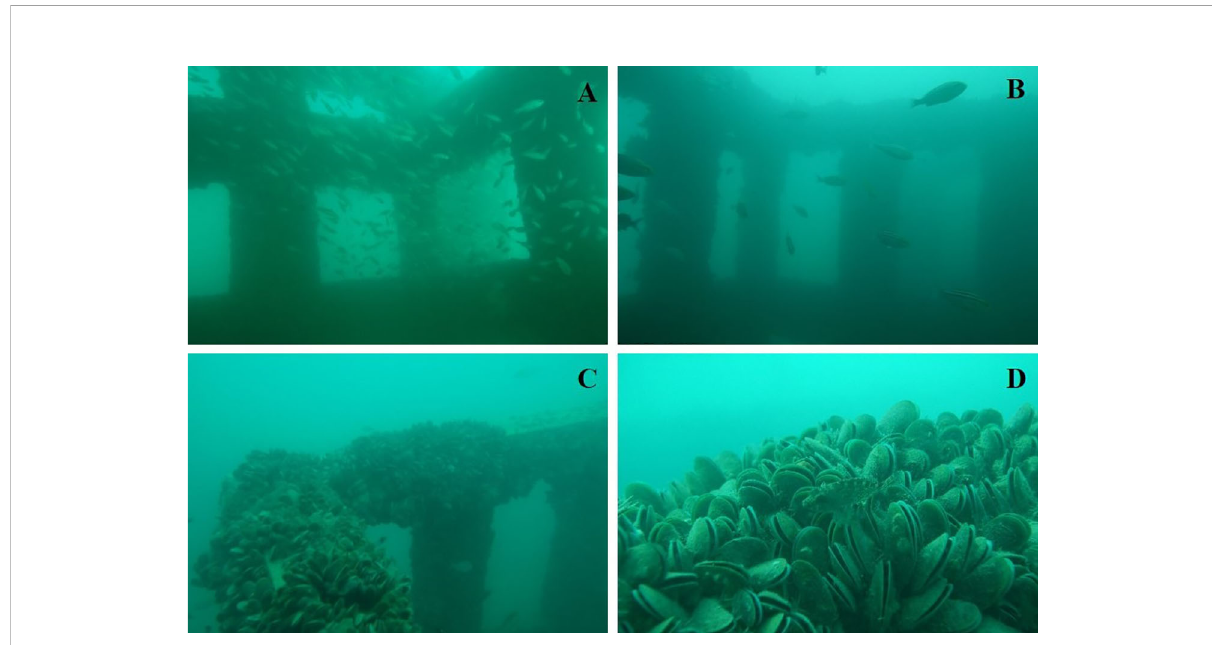
FIGURE 3 Underwater photos of fi sh aggregation in arti fi cial reefs (A, B) and living organisms attached to reefs (C, D) in Dalajia, Daya Bay,